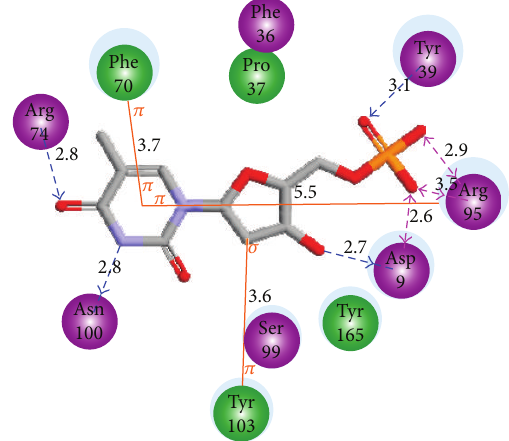
Figure 1: Interaction of dTMP with active site residues of TMPK mt